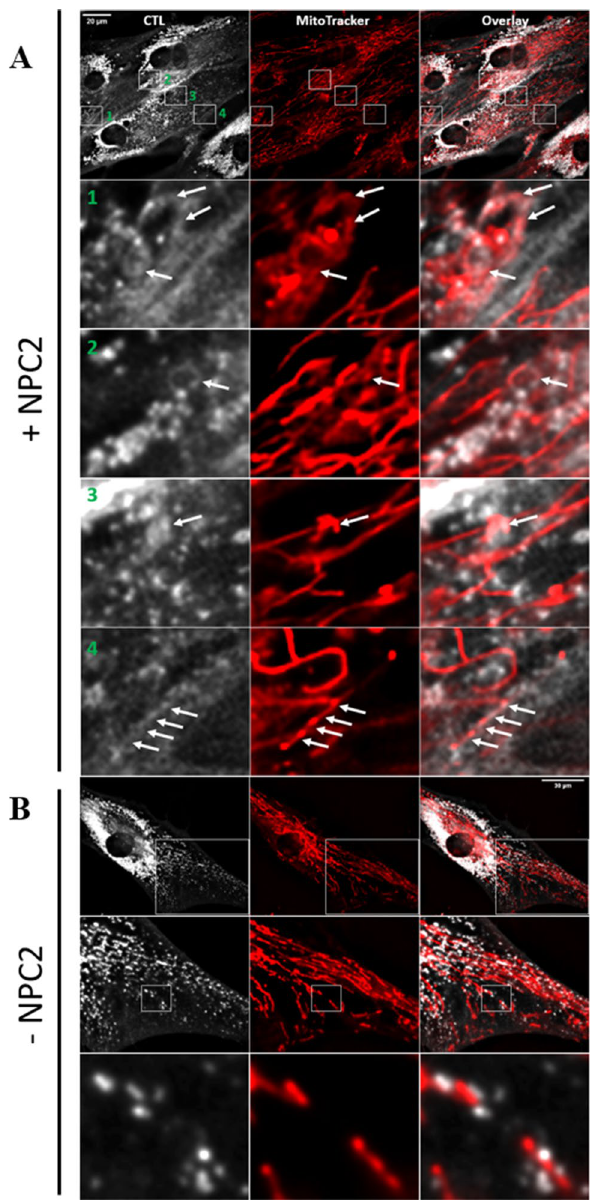
Figure 1. Direct observation of sterol transport to mitochondria. Human fibroblasts of a NPC2-disease patient (NPC2−/− fibroblasts) were loaded with 20 μM CTL, from a CTL/BSA complex for 48 h in LPDS medium and subsequently chased for 24 h in LPDS medium with ( A ) or without ( B ) 200 nM NPC2 protein, and co-stained with MitoTracker green before imaging on an UV sensitive wide field microscope. Arrows point to CTL in mitochondria. Insets in panel A (numbered 1–4) are shown as zooms below the first row. The inset in the upper row of panel B is shown as zoom underneath in which another inset is indicated as white box and zoomed as lowest row. Bar, 20